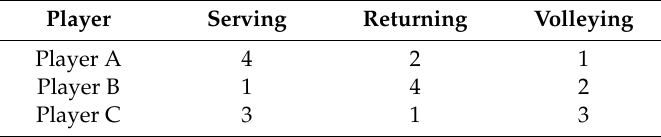
Table 3. Skills of three tennis players in a simple model. Player Serving Returning Volleying